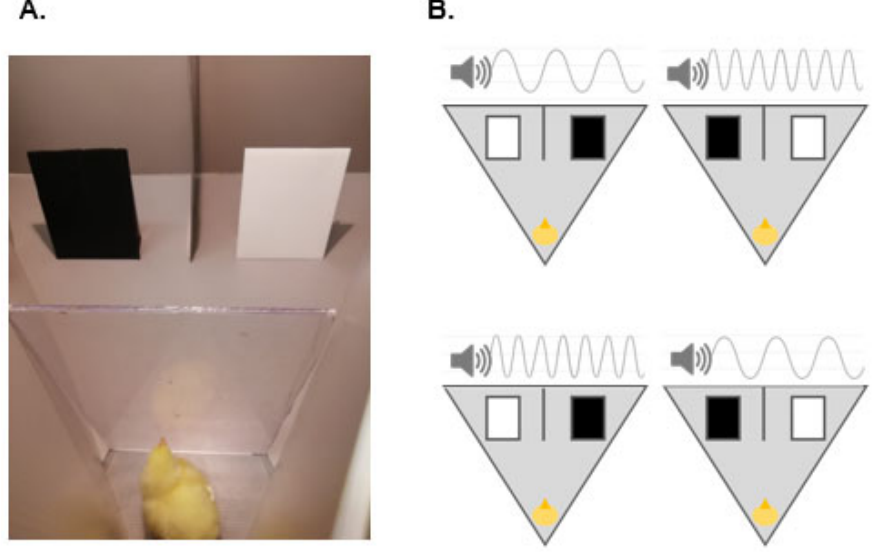
Figure 2. Test: ( A ). The chick restrained in the starting position can see both panels: one on the left (in this example, the black one), and one on the right (in this example, the white one) of the vertical partition. When the glass partition is removed, the chick is let free to approach either panel. The trial is ended when the chick circumnavigates either panel with at least 2/3 of its body, including the head. ( B ). Each chick undergoes 20 consecutive trials, in which 4 possible combinations are alternated in semi-random order (i.e., the same combination never occurs more than twice in a row. The trials differ for the spatial position of the black and white panel (i.e., left, or right) and for the pitch of the background audio (i.e., high, or